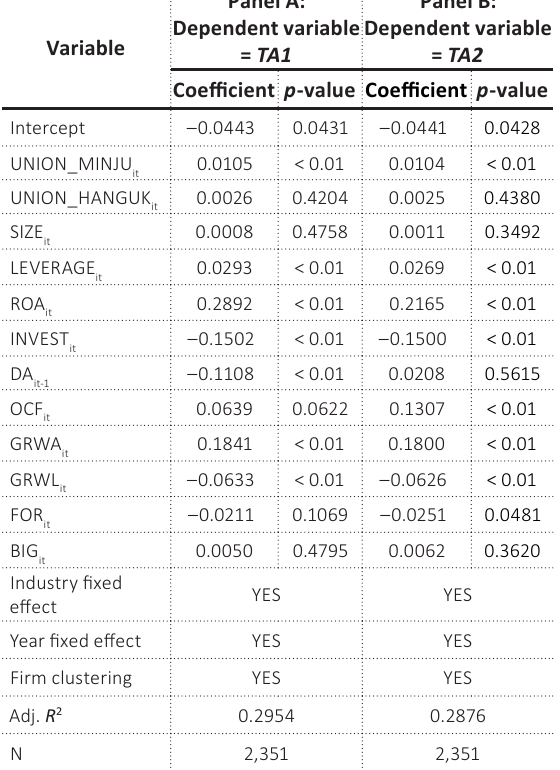
Table 5. Sensitivity test: labor union and tax avoidance activities for chaebol vs. non-chaebol firms Chaebol